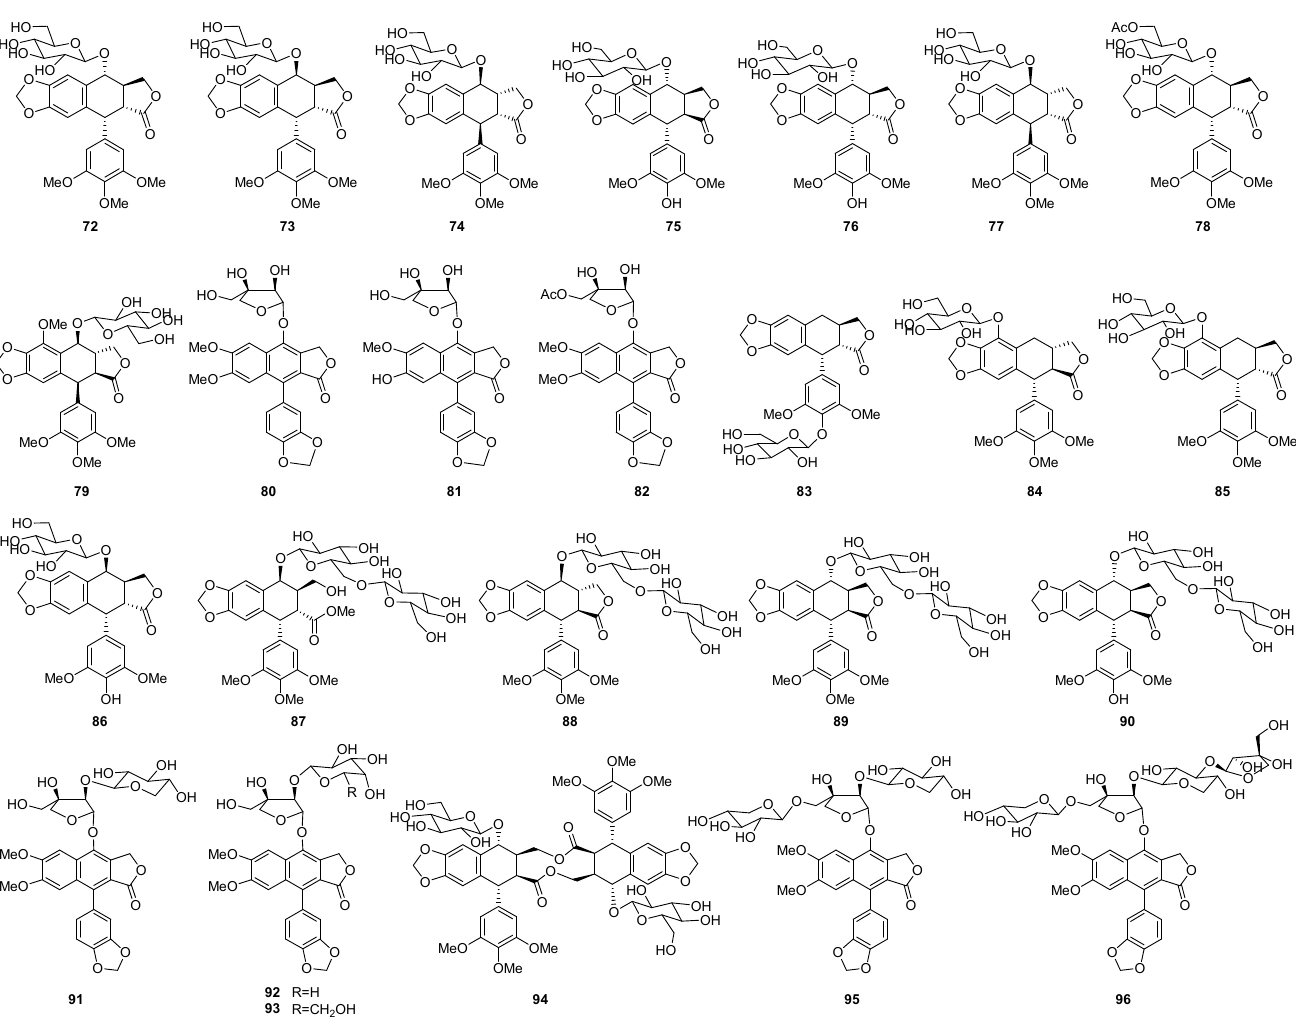
Figure 3. Chemical structures of natural podophyllotoxin glycosides. Table 1. Podophyllotoxins and their plant resources.